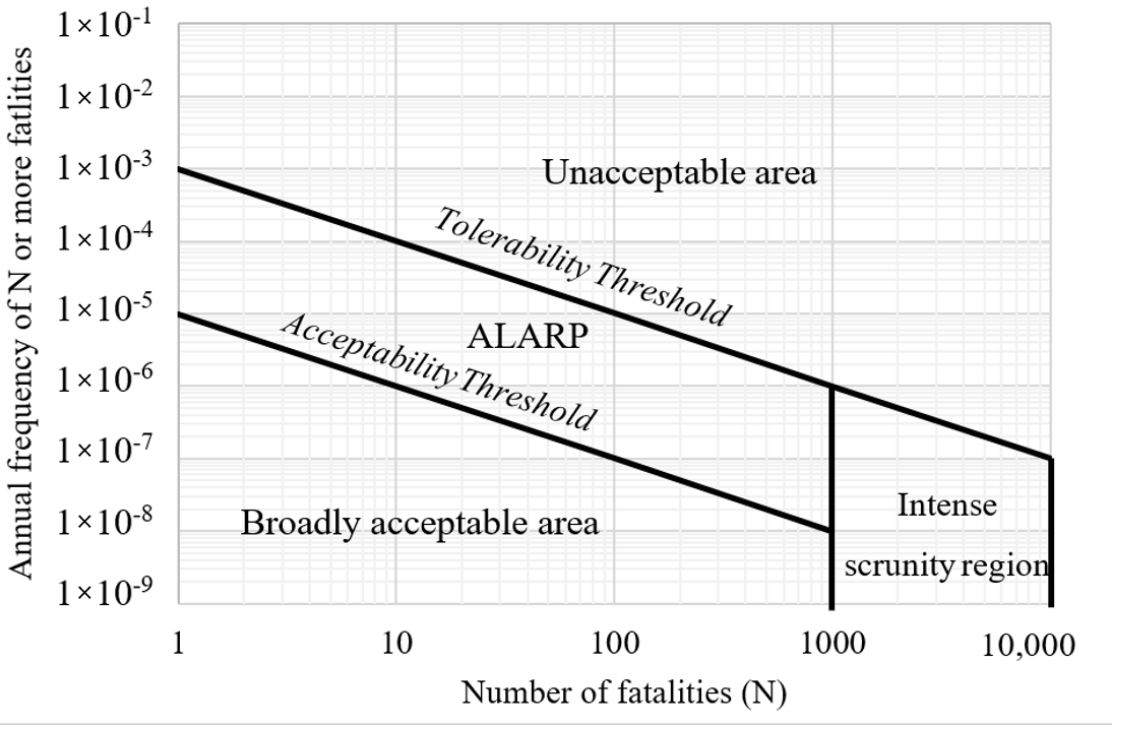
Figure 3. Societal risk evaluation criteria: example of a risk curve on the F-N plane.